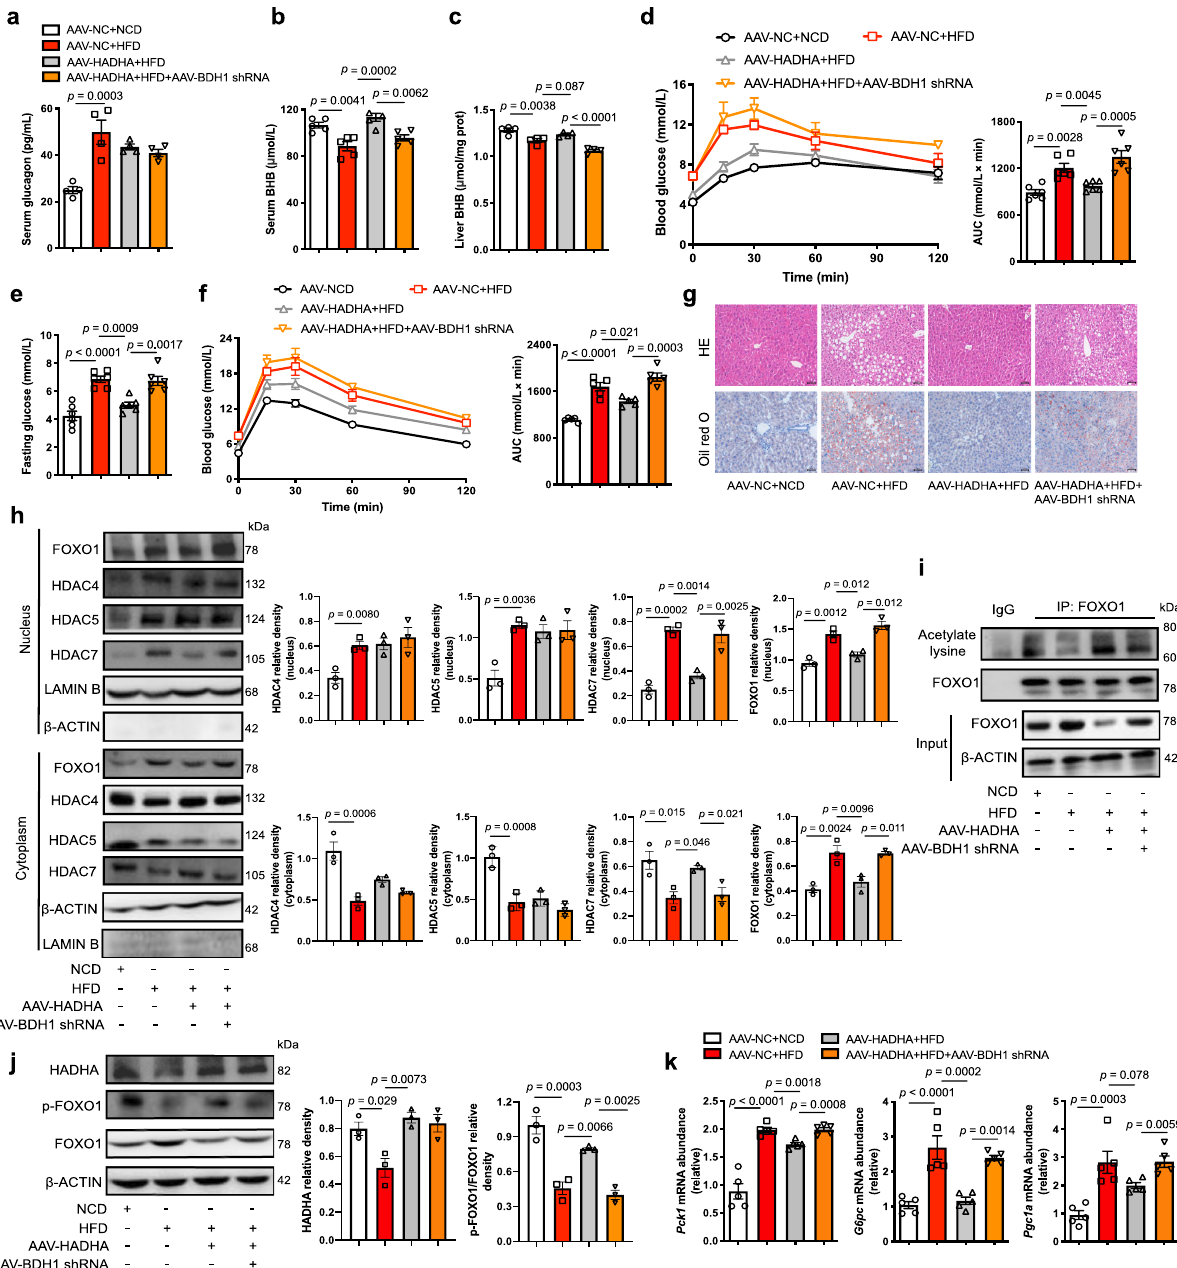
Fig. 7 HADHA suppressed hepatic glucagon response dependent on BDH1 in HFD-fed mice. Eight-week-old mice injected with AAV8-NC, AAV8- HADHA or AAV8-BDH1 shRNA were fed with NCD or HFD for 12 weeks. a Serum glucagon contents in mice ( n = 4). b, c BHB contents in serum and liver ( b : n = 5; c : n = 4). d Pyruvate tolerance test (2 g/kg body weight) after 11 weeks of feeding. AUC is indicated on the right ( n = 6). e Fasting blood glucose after 12 weeks of feeding ( n = 6). f Oral glucose tolerance test (2.5 g/kg) after 12 weeks of feeding. AUC is indicated on the right ( n = 5). g Representative images of HE and Oil Red O-stained liver sections ( n = 3). h Protein expressions of FOXO1, HDAC4, HDAC5 and HDAC7 in nucleus and cytoplasm of liver ( n = 3). i Hepatic FOXO1 acetylation levels. It was repeated 3 times independently with similar results. j Western blotting analysis of HADHA and FOXO1 phosphorylation in the liver ( n = 3). k Relative mRNA levels of Pck1 , G6pc and Pgc1a in the liver ( n = 5). AAV adeno-associated virus, AUC area under the curve, BHB β -hydroxybutyrate, HFD high-fat diet, NCD normal chow diet. Values represent mean ± SEM. Statistical differences were determined by one- way ANOVA. Source data are provided as a Source Data fi